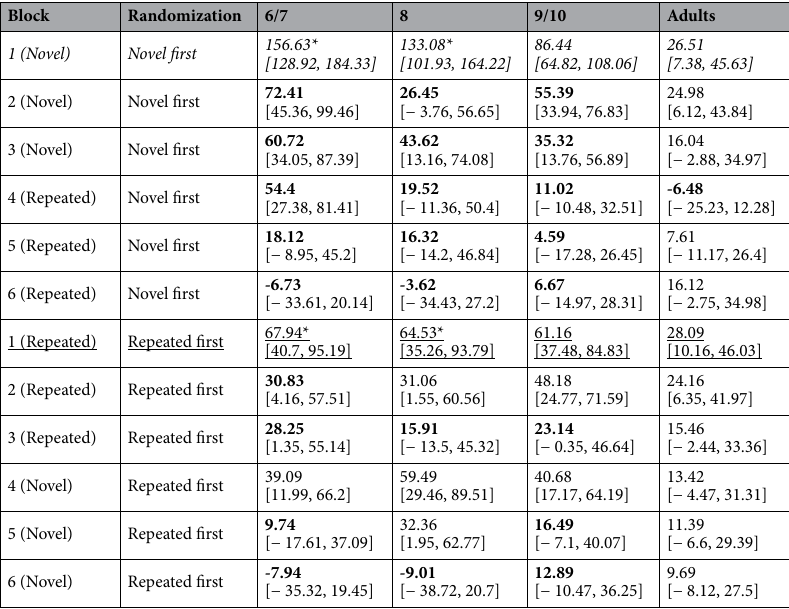
Table 5. Distraction effects in each block and for each randomization separately for all age groups. The (cid:31) RT (cid:31) RT values are distraction effects (i.e., distractor − standard ) in the respective combination of group, block and randomization. Positive values indicate slower responses in the presence of distractor sounds. 95% confidence intervals are given in square brackets. Italic marked line highlights the first novel block when the novel condition was presented first, underline highlights the first repeated block when the repeated condition was presented first. Asterisks mark significantly increased distraction effects in the novel condition compared to the repeated condition in the first block in both youngest age groups (non-overlapping CIs of the respective differences: CIs [49.83, 127.54] for 6–7-years-olds and [25.81, 111.29] for 8-years-olds). Bold print marks blocks that significantly differ from the respective first block (on the basis of CIs of difference values in Table A4 for which CIs did not overlap with